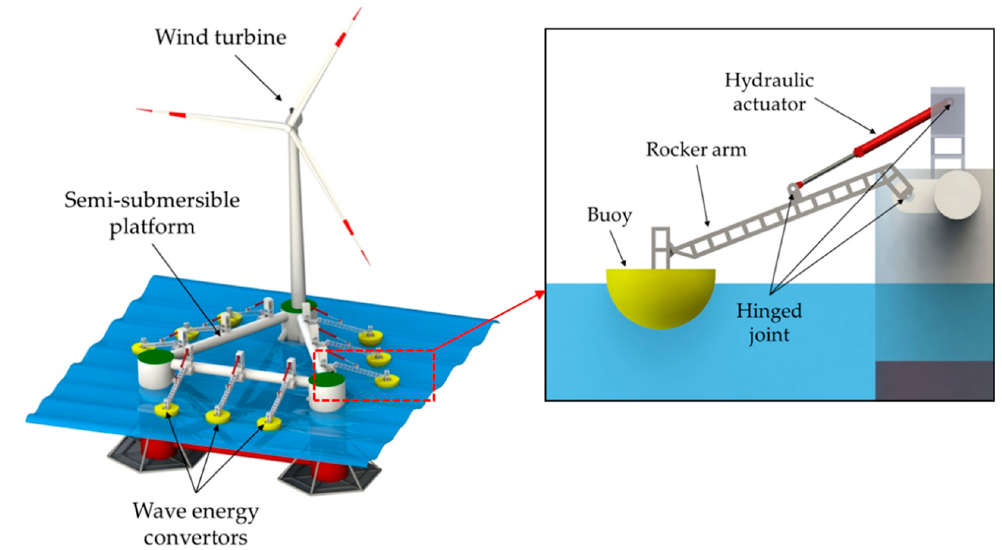
Figure 1. Conceptual design of the floating hybrid wind-wave platform system.